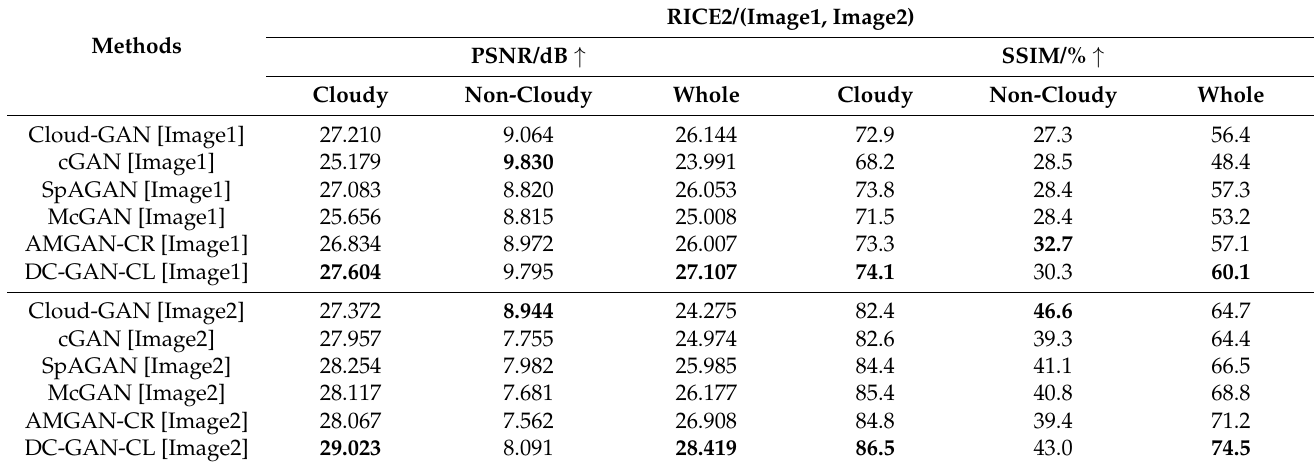
Table 6. Quantitative evaluation of various methods on RICE2/(Image1,